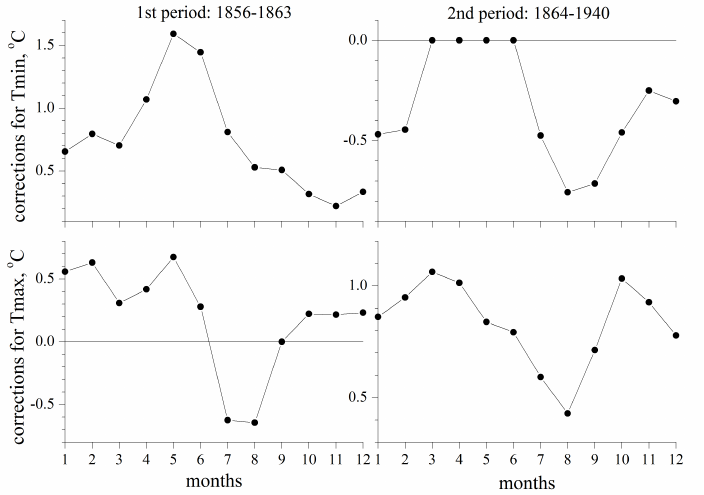
Figure 14. Lisbon: corrections (in ◦ C) for T min (top panels) and T max (bottom panels) series for two periods between the breaks 1856–1863 (left panels) and 1864–1940 (right panels).